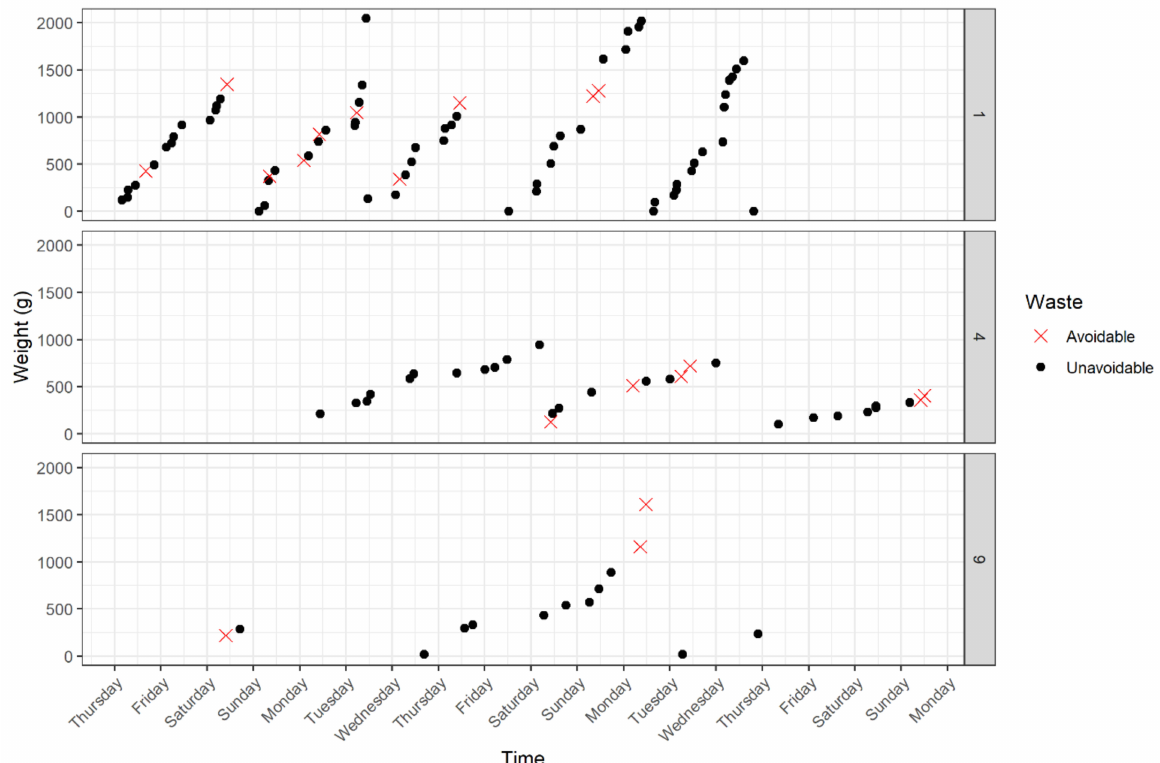
Figure 4. Waste over time from households 1, 4 and